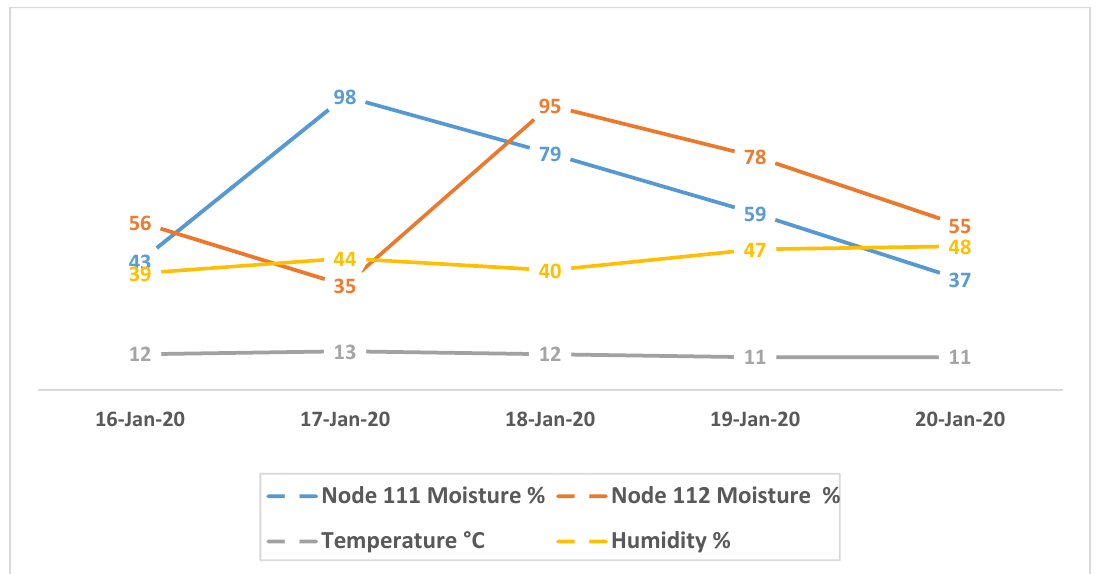
Figure 12. Historical soil moisture and weather data of node 111 and node 112